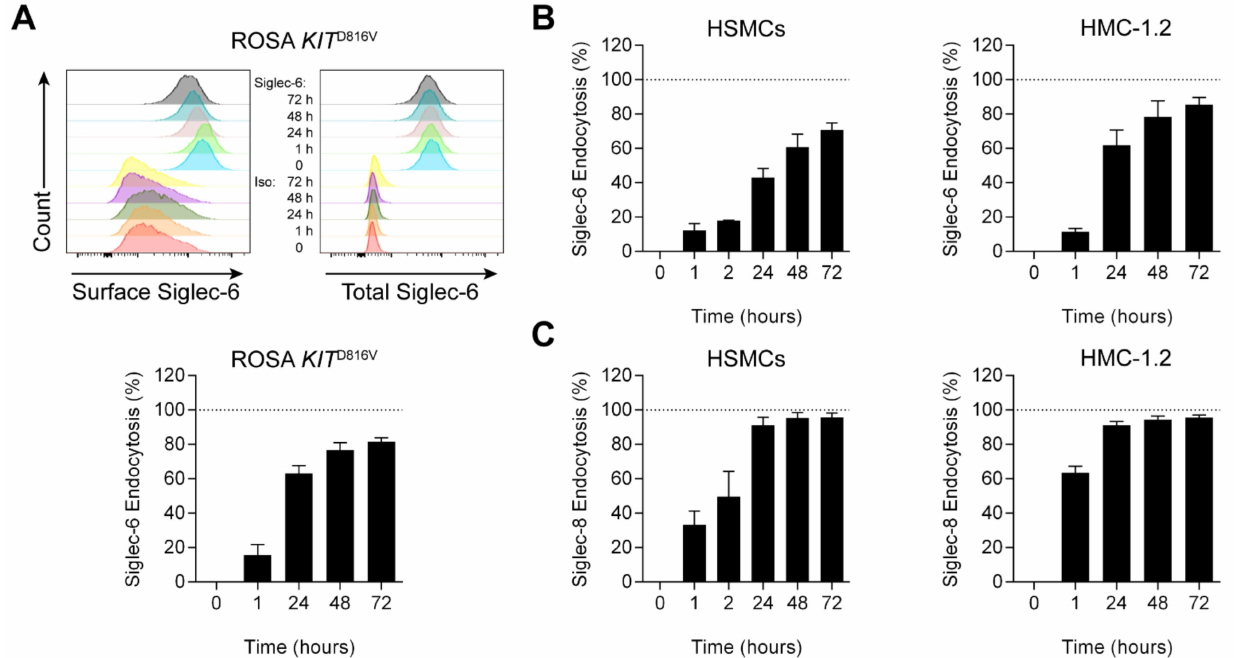
Figure 3. Siglec-6 is stable at the surface of MCs and is slowly internalized following antibody ligation. ( A ) Delayed fluorophore-conjugated secondary mAb detection of anti-Siglec-6 mAb was used to assess Siglec-6 levels remaining on the surface of ROSA KIT D816V cells (Surface Siglec-6) following antibody ligation after various durations. Fluorophore-conjugated anti-Siglec-6 mAb was used to assess both cell-surface and internalized Siglec-6 (Total Siglec-6) on ROSA KIT D816V cells. Isotype control mAb (Iso) is used as a negative control in both strategies. Because loss of total Siglec-6 was not observed, Siglec-6 endocytosis was calculated based on the loss of cell-surface Siglec-6 on ROSA KIT D816V cells ( A ), as well as HSMCs and HMC-1.2 cells ( B ). Siglec-8 endocytosis was similarly determined on HSMCs and HMC-1.2 cells ( C ). Data are representative (histograms) or represent the means and standard deviations of three independent